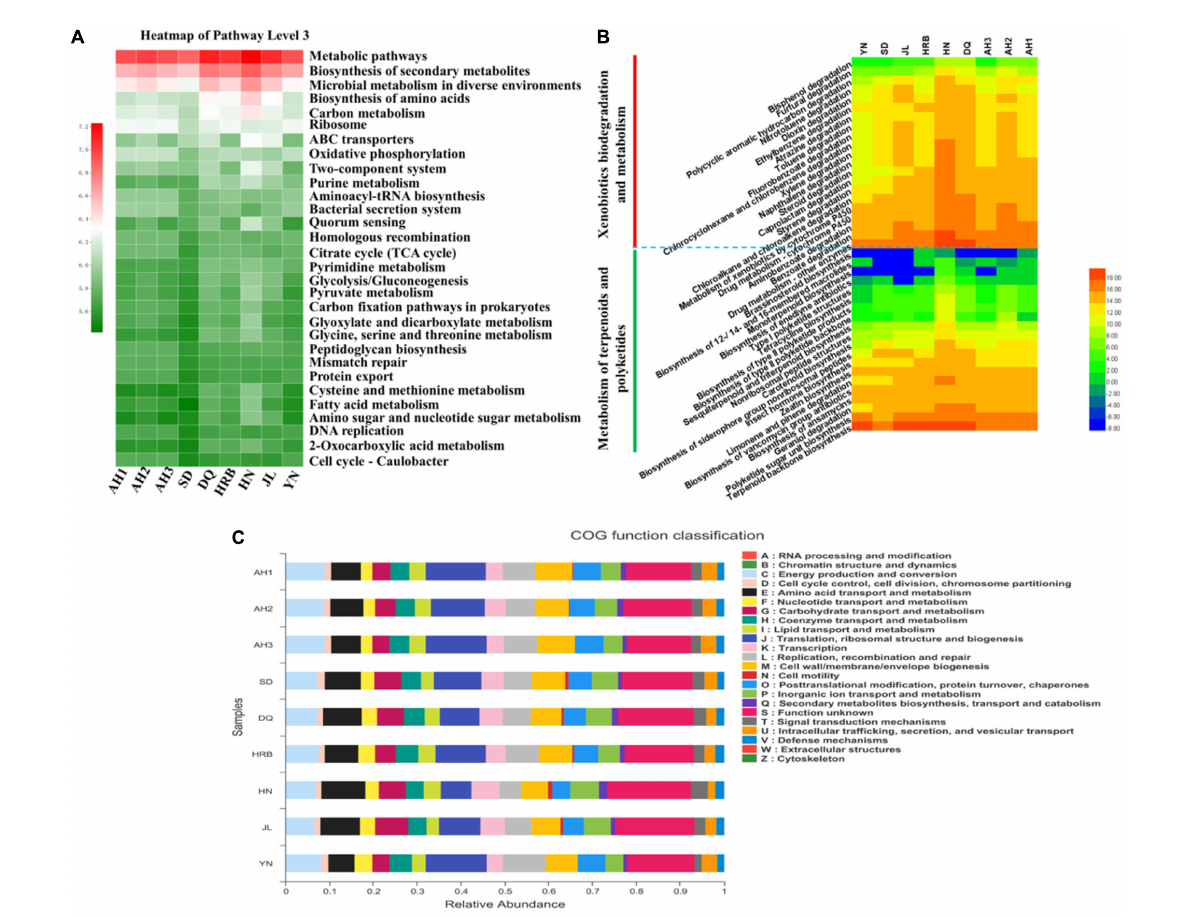
FIGURE5 Comparison of predicted KEGG pathways and COG functions among nine geographic populations of the hemp flea beetle P. attenuata in China by PICRUSt2. (A) The relative abundance of KEGG pathways prediction based on level 3. (B) The relative abundance of metabolism pathways. The inferred metabolic pathways are shown with xenobiotics biodegradation and metabolism and metabolism of terpenoids and polyketides in the pathway level 2, which belong to the metabolism in pathway level 1. (C) The relative abundance of predicted COG